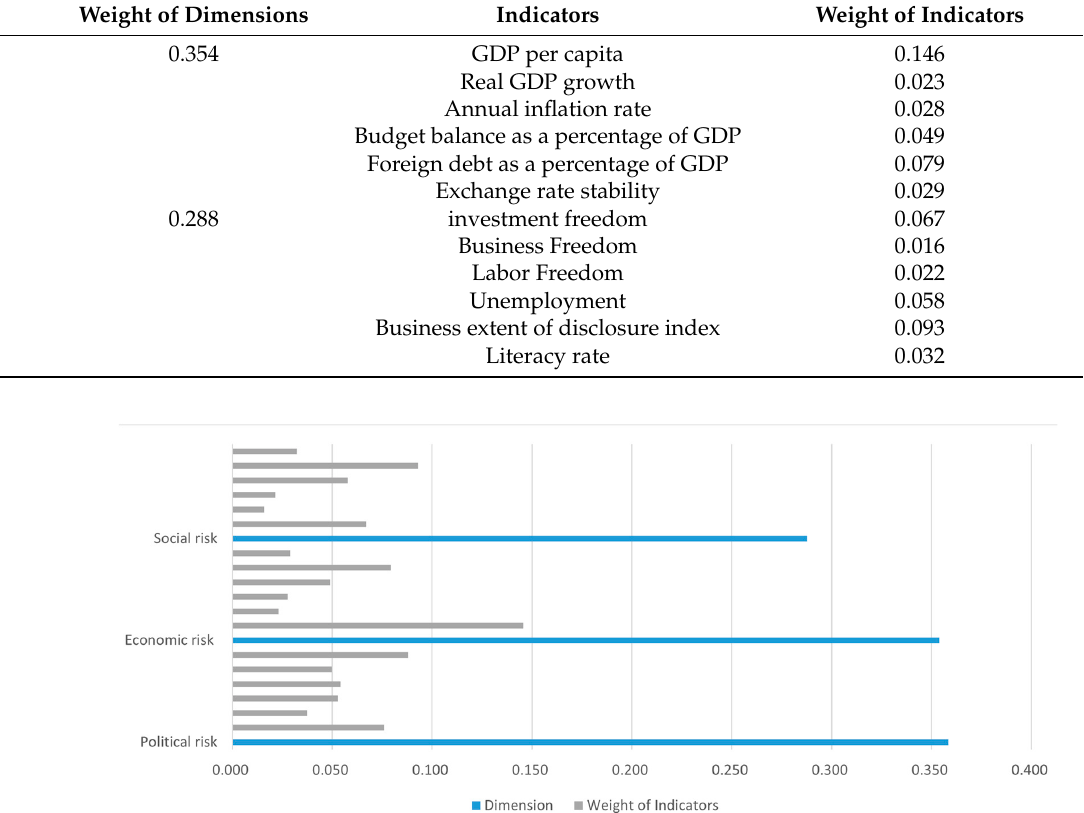
Figure 4. The results of the national investment risk evaluation based on 3-D evaluation. Figure 5. The results of the national investment risk evaluation based on 6-D evaluation. 4.2. Comparison of Numerical Trends Table 6 shows risk evaluation results in Southeast Asia and Central Asia along the BRI. The proposed approach in this research is compared with three existing evaluation